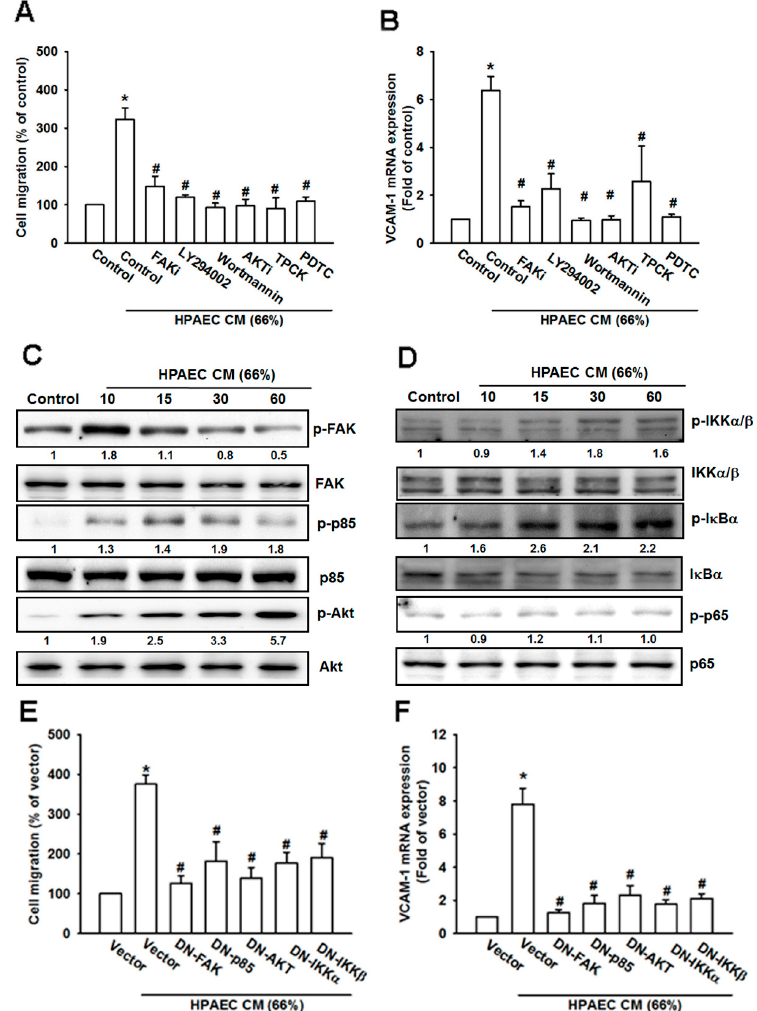
Figure 5. HPAECs CM increases VCAM-1 expression and cell mobility via the FAK / PI 3 K / Akt / NF- κ B signaling cascade. ( A ) MG63 cells were pretreated with FAK, PI 3 K, Akt, and NF- κ B inhibitors (FAKi, LY294002, Wortmanin, Akti, TPCK, and PDTC) for 90 min and seeded in the upper chamber of the Transwell plate; then the HPAECs CM was placed in the lower chamber, and cell migration was evaluated after 20 h. ( B ) MG63 cells were pretreated with FAK, PI 3 K, Akt, and NF- κ B inhibitors (FAKi, LY294002, Wortmanin, Akti, TPCK and PDTC) for 90 min and then incubated with HPAECs CM for 24 h. VCAM-1 expression was investigated by qPCR. ( C , D ) MG63 cells were incubated with HPAECs CM for di ff erent time intervals (0, 10, 15, 30, or 60 min). Total protein was collected and phosphorylation of FAK, p85, Akt, IKK α / β , I κ B α , and p65 was determined by Western blot. ( E ) MG63 cells were transfected with FAK, p85, Akt, IKK α , and IKK β DN mutants for 24 h and then subjected